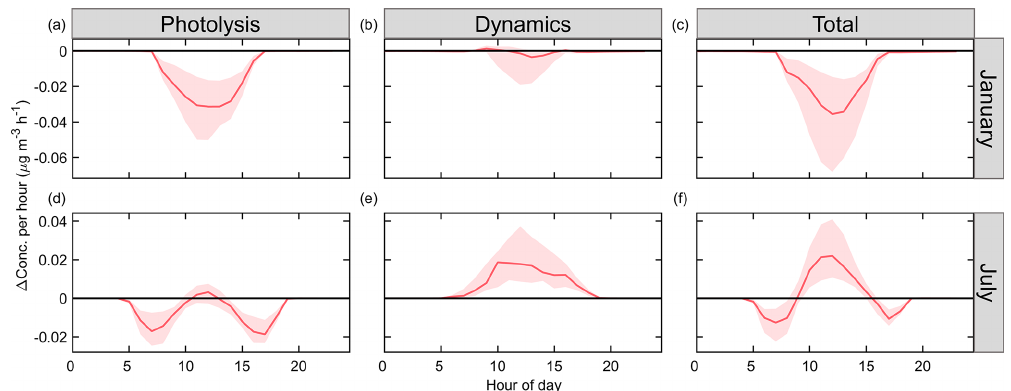
Figure 6. Diurnal variances of ADE impact on AERO of sulfate in January and July. The red line and shadow depict the medium value and 25th to 75th percentiles, respectively.